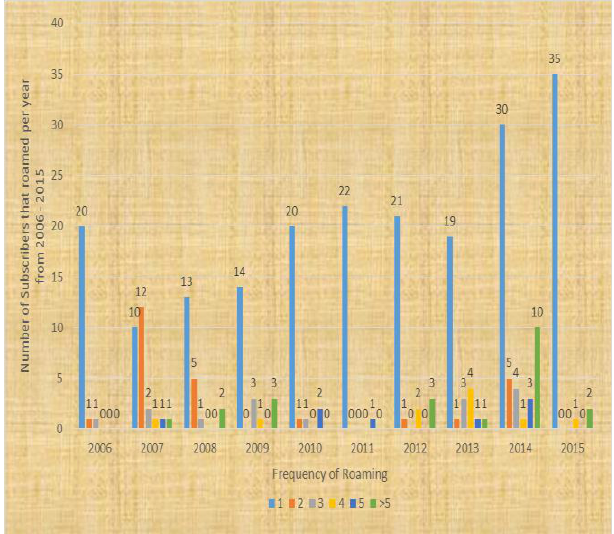
Figure A.2. Annual Roaming